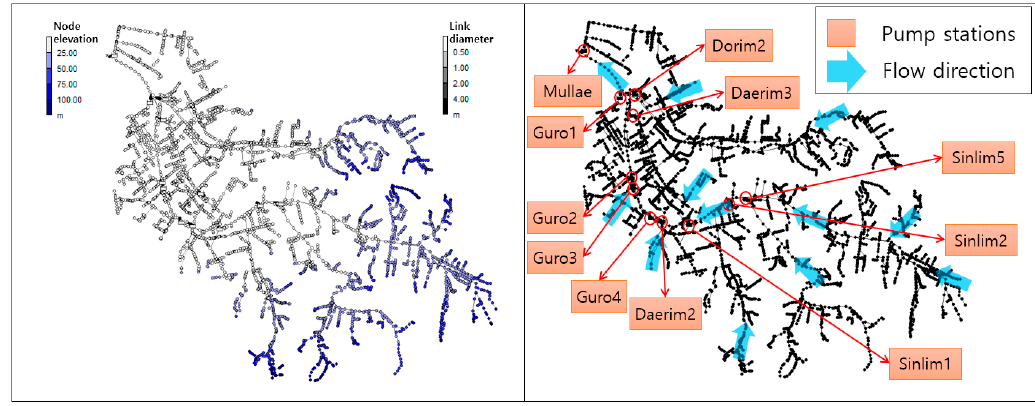
Figure 8. The sewer network in the target watershed.